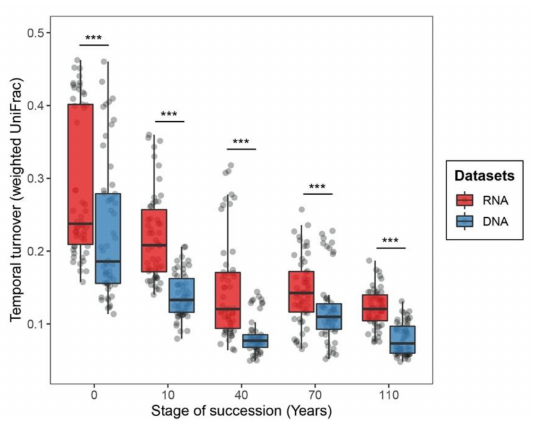
Figure 3. Boxplots displaying the temporal variation of RNA- and DNA-inferred communities along the soil successional stages. The temporal variation was based on weighted UniFrac distances of communities across distinct sampling time points. *** indicates p < 0.001 in Wilcoxon signed-rank test.